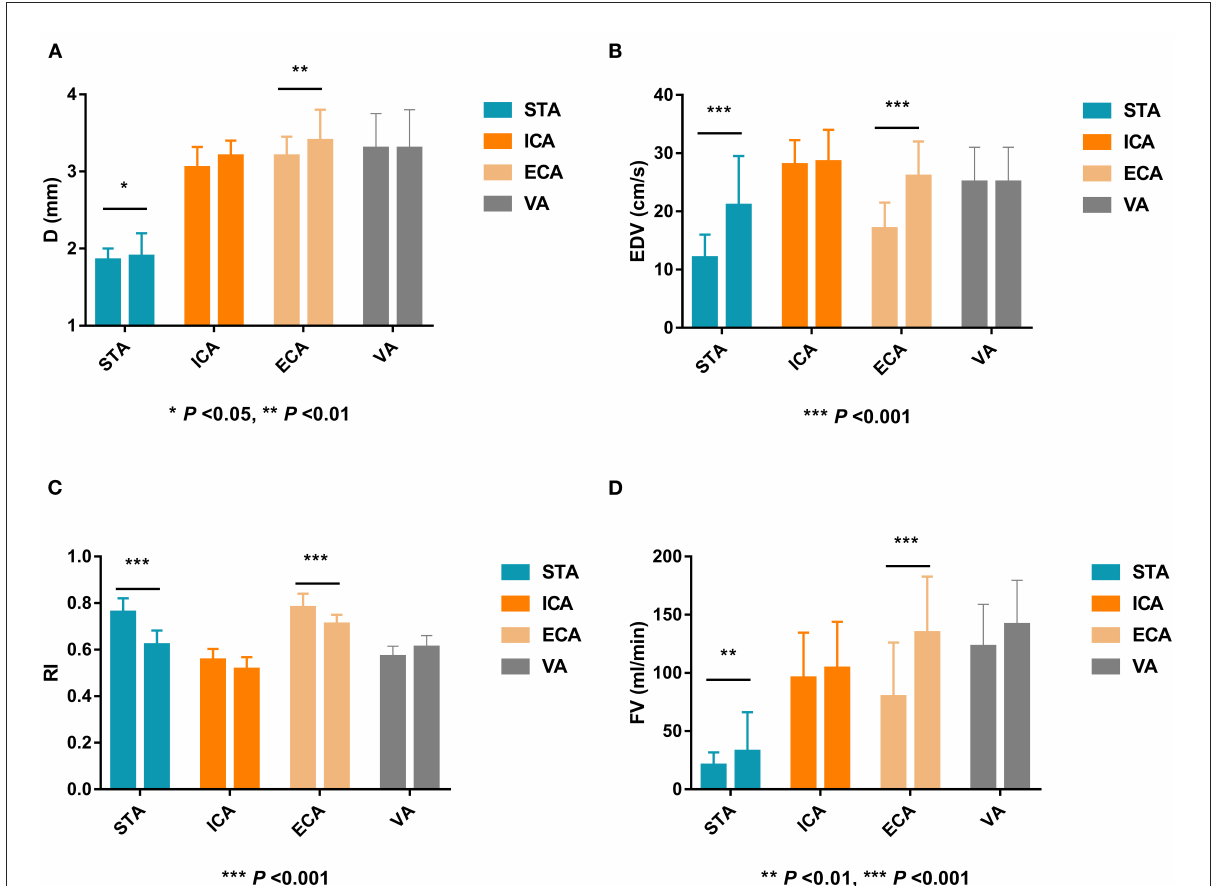
FIGURE2 Ultrasonographic changes of extracranial arteries before and after STA-MCA anastomosis in MMD patients. STA, superficial temporal artery; MCA, middle cerebral artery; MMD, indicates moyamoya disease; D, inner diameter; ICA, internal carotid artery; ECA, external carotid artery; VA, vertebral artery; EDV, end-diastolic velocity; RI, resistance index; FV, flow